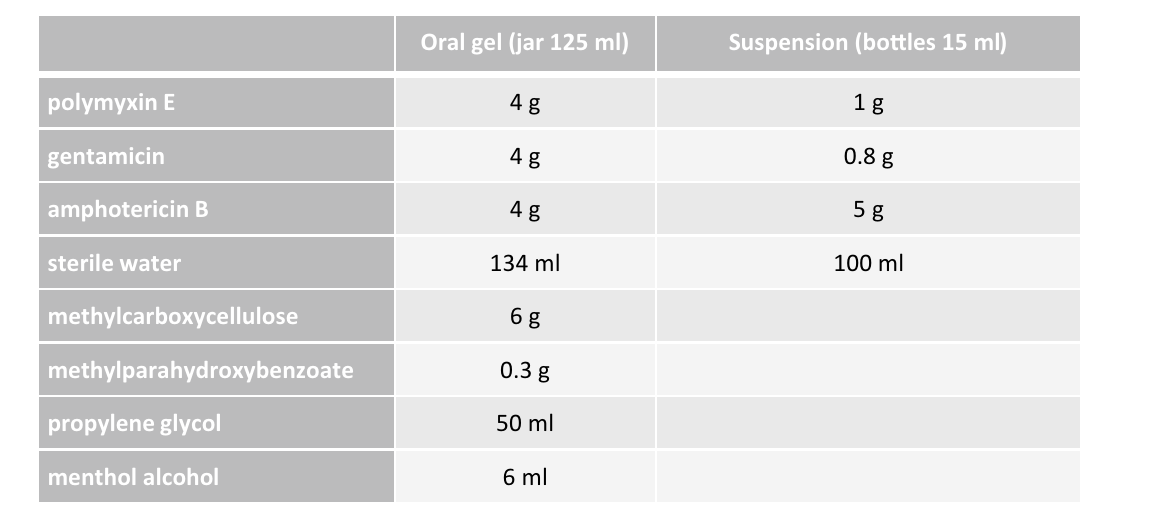
Fig. 2 Selective digestive decontamination protocol (expert